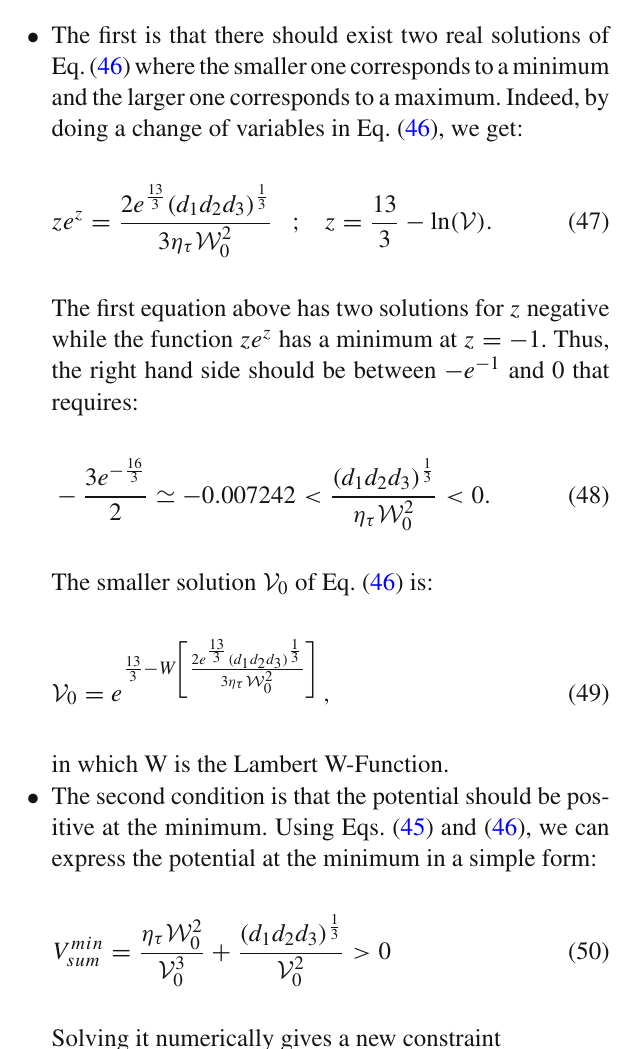
The potential (37) is plotted in Fig.